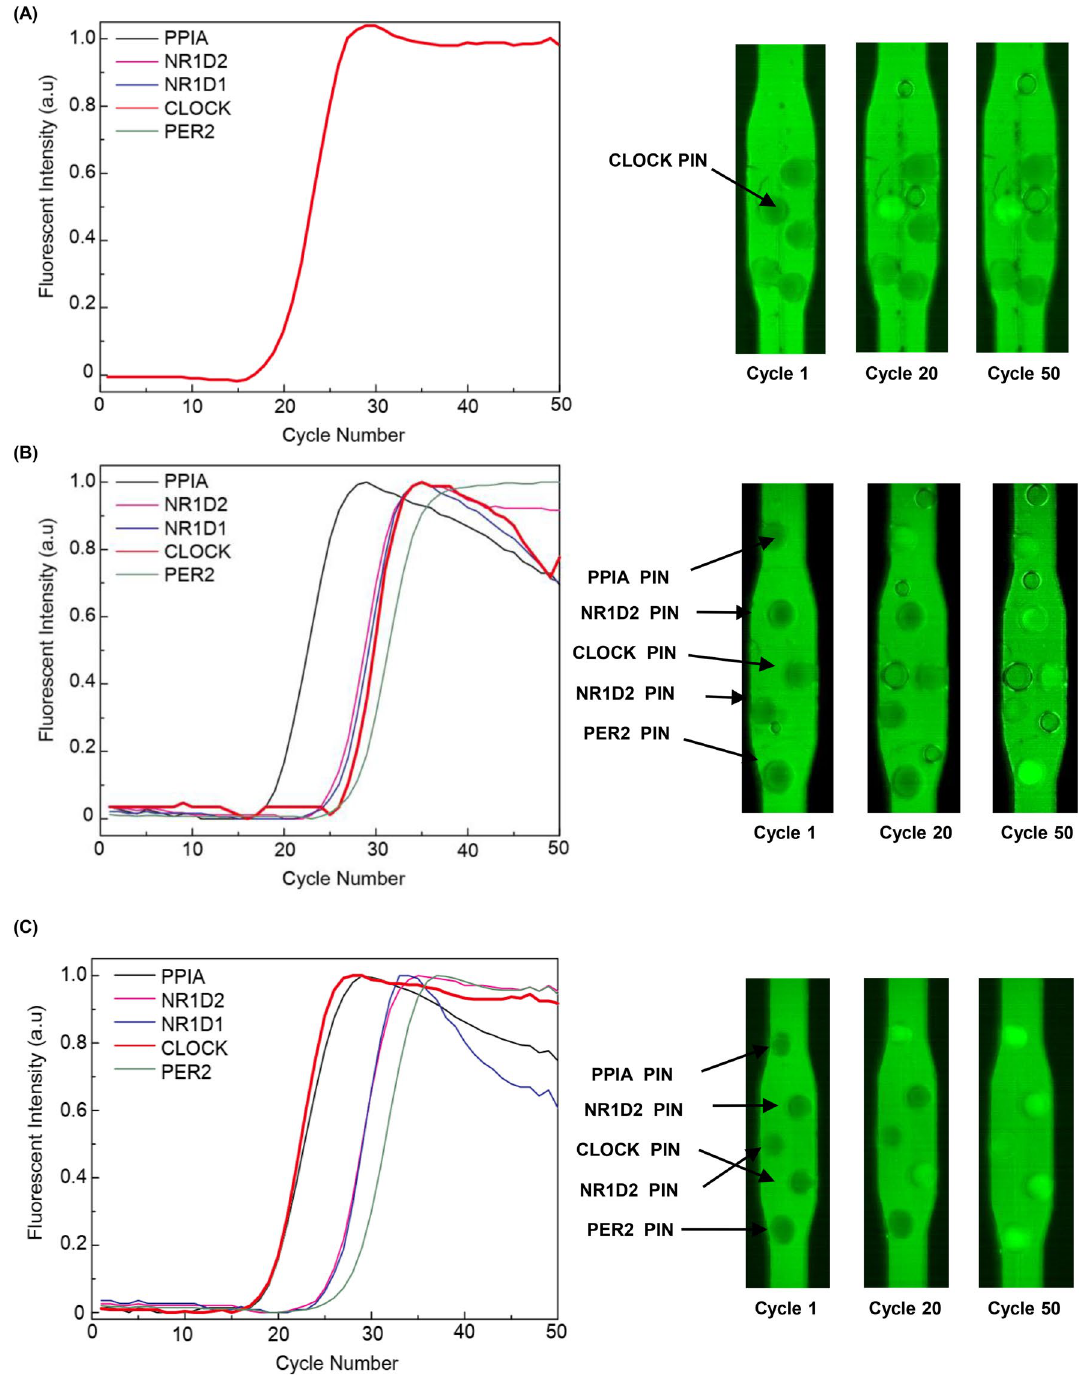
Figure 3. Multiplex spike in one step RT-qPCR assay for various genes and their corresponding fluorescence images. ( A ) Spike in RT-qPCR strategy for CLOCK IVT RNA in which the microparticle targeting only the CLOCK gene was brightened. ( B ) Spike-in RT-qPCR process for HeLa total cell RNA. ( C ) Spike in approach for CLOCK IVT RNA in HeLa total cell RNA CLOCK particle proceeded without interruption with an early C t value of 19.1 from 26.9 Fluorescence signals of the multiplex qPCR with five different PIN particles showed specific fluorescence signals for the